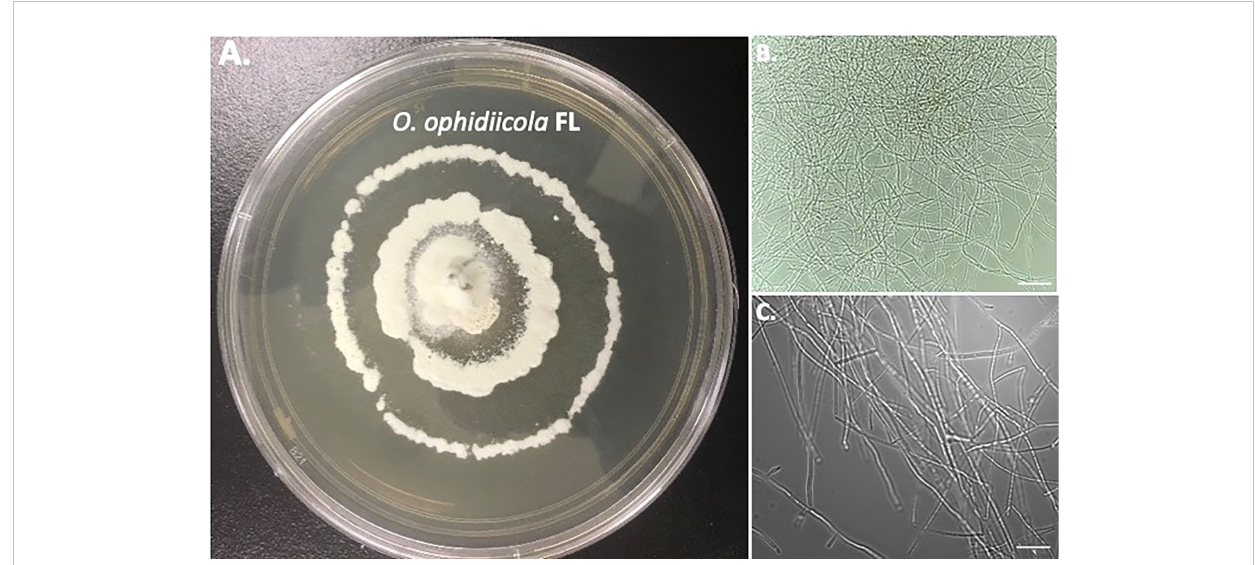
FIGURE 4 Colony and Microscopic Features of O. ophidiicola FL. Comparison of colony formation SDA plates: O. ophidiicola FL (A) Light microscope images of hyphae phase: O. ophidiicola FL (B, C) . Bars: B = 150 m m; C = 75 m m.